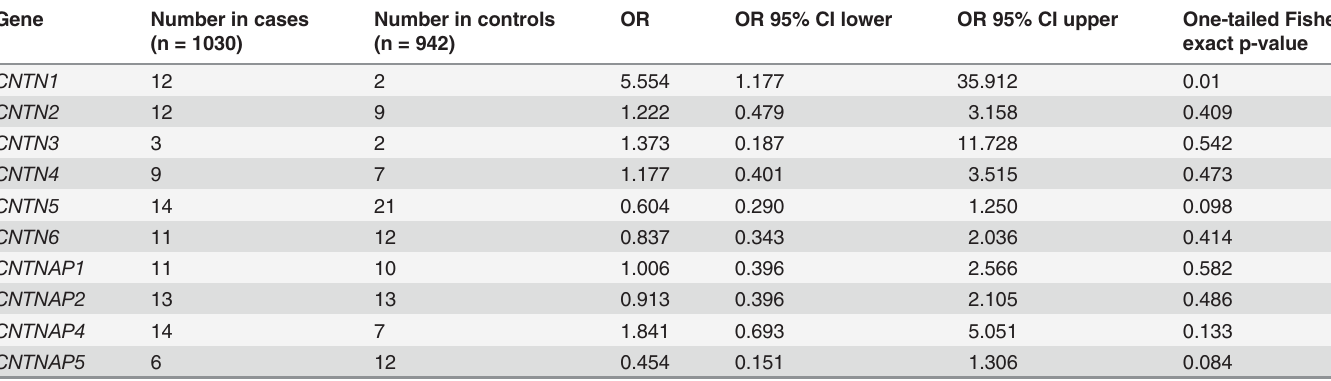
Table 3. Rates of mutation predicted deleterious * by SIFT-or-PolyPhen2: all genes. Gene Number in cases (n =